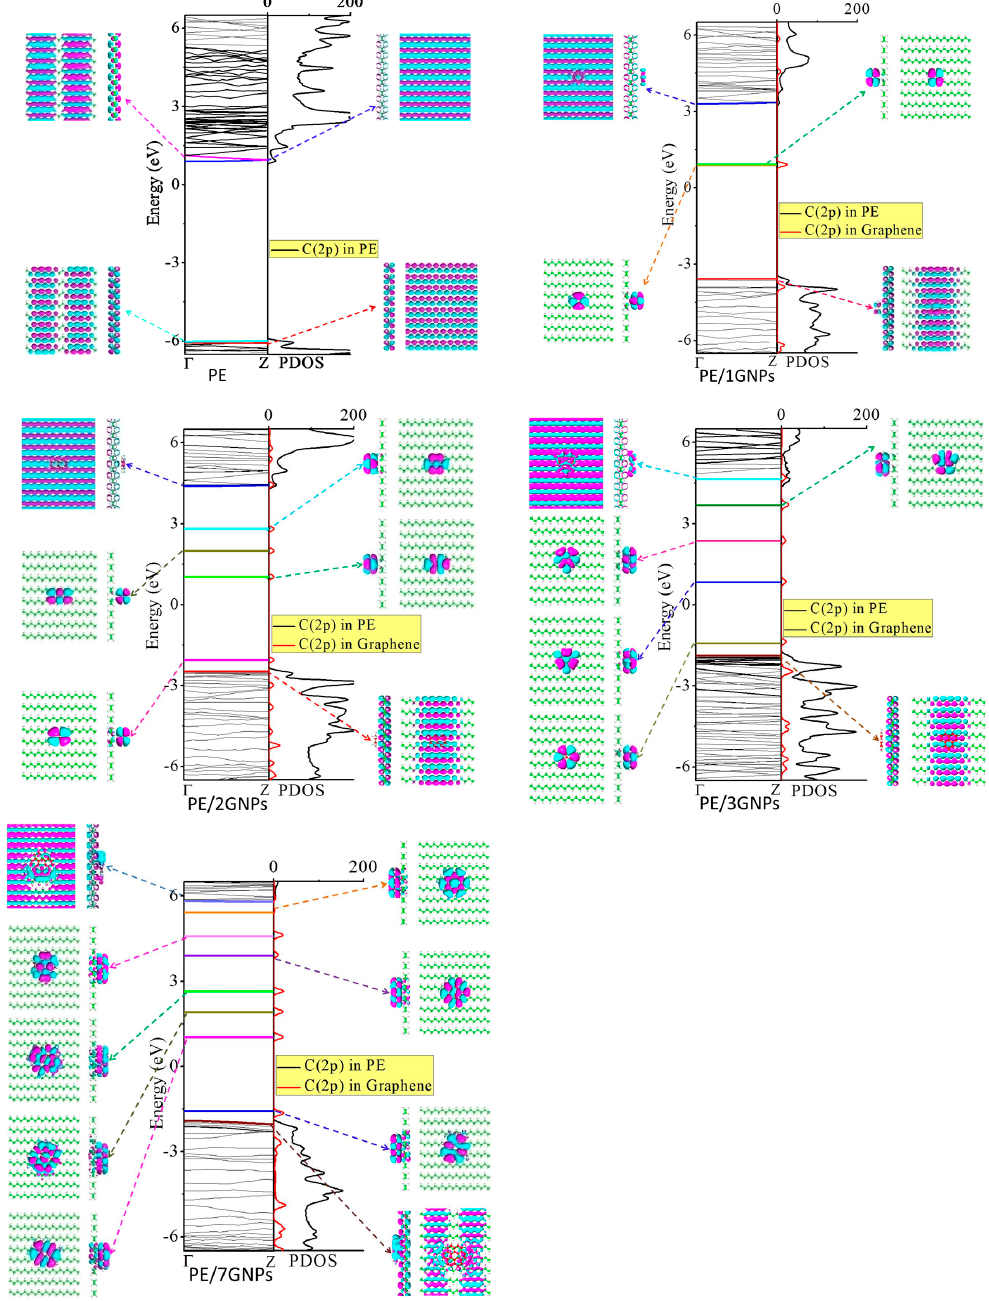
Figure 4. Calculated band structures and PDOS of PE, PE/1GNPs, PE/2GNPs, PE/3GNPs, and PE/7GNPs and the Kohn-Sham orbitals corresponding to the energy levels (highlighted in color lines) near E f at the Γ point. The iso-surface value is 0.005 eV.